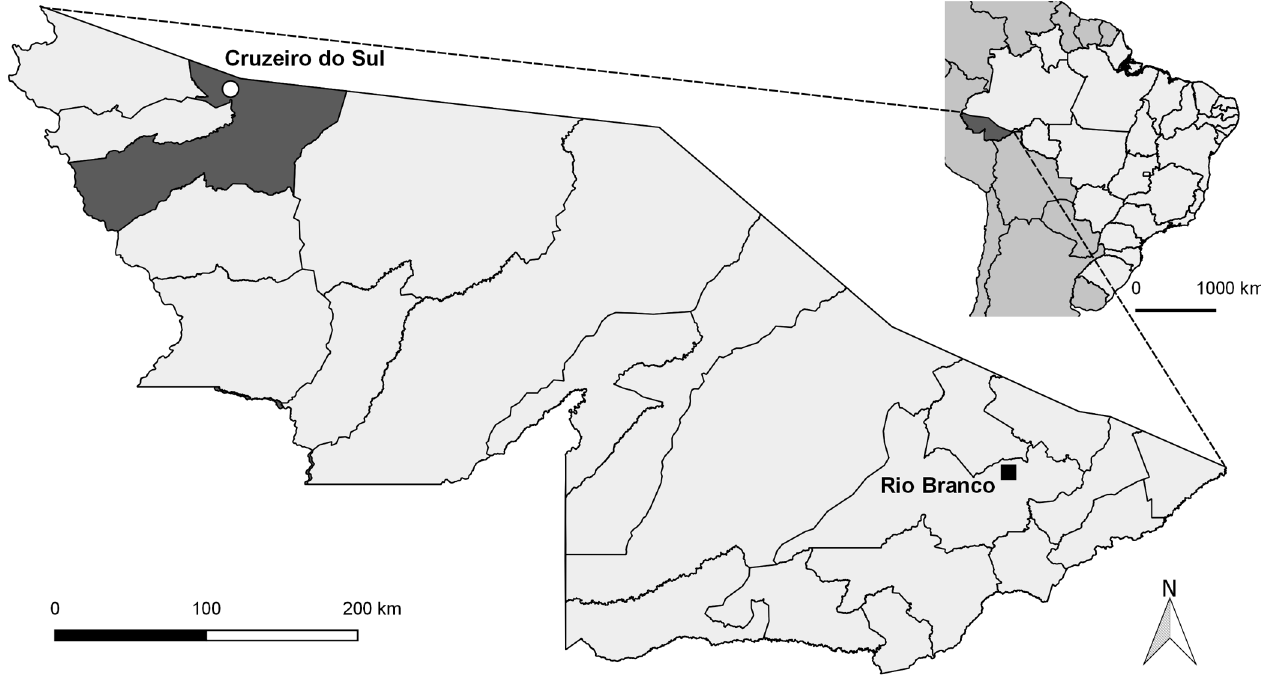
Fig 1. Map showing the geographic location of Cruzeiro do Sul, Acre State, Brazilian Amazon. Cruzeiro do Sul has an estimated population of 82,075 inhabitants. The map also indicates Rio Branco, the capital of Acre state.